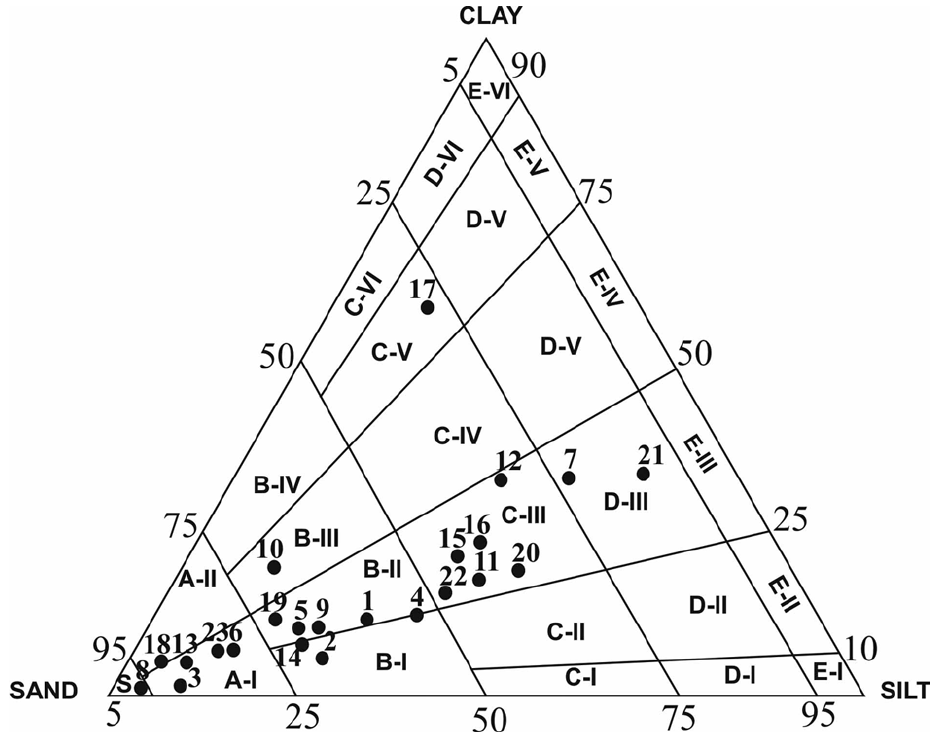
Fig. 3 – Triangular diagram of textural classes (Flemming 2000). Subdivisions are based on sand/silt/clay percentages.